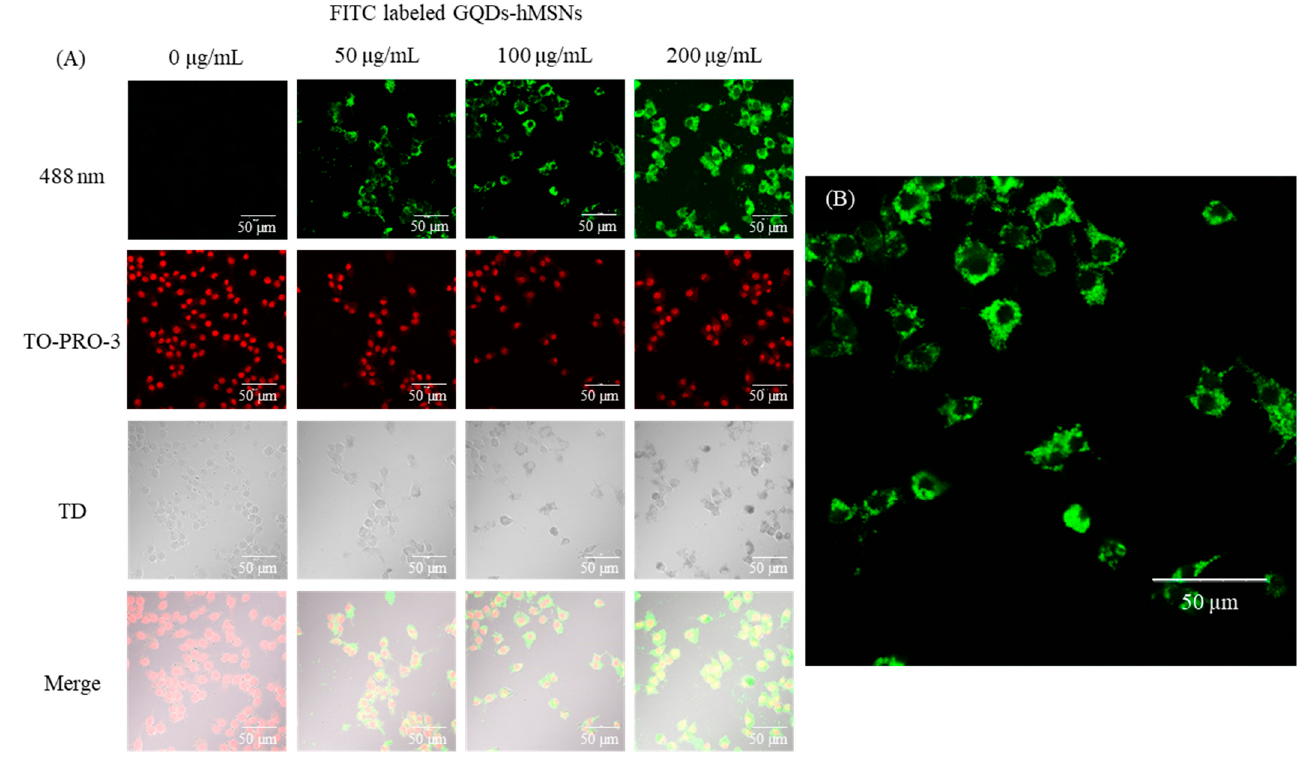
Figure 11. In vitro images of RAW 264.7 cells with GQDs-hMSNs doped with FITC dye as the mock drug. ( A ) 0, 50, 100, and 200 µg/mL cell cultures with TO-PRO-3 labeled nucleus. ( B ) 100 µg/mL GQDs-hMSNs with FITC.